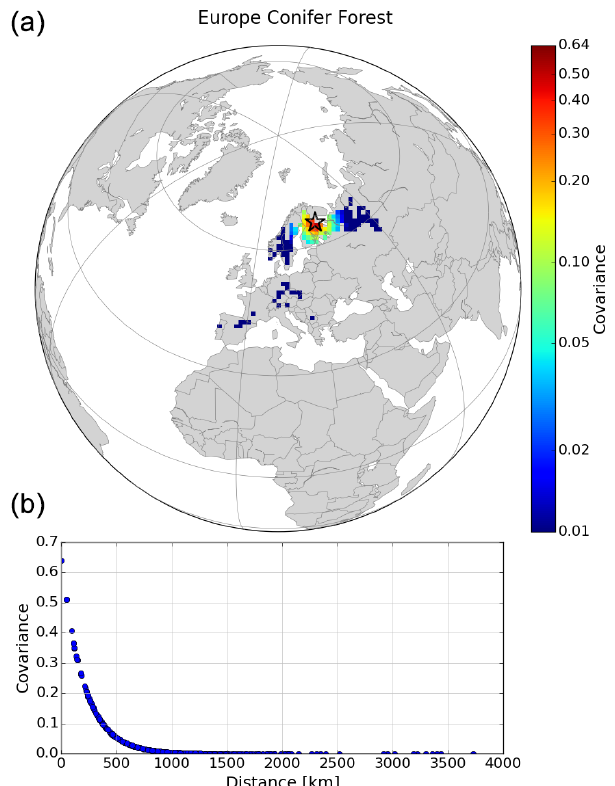
Figure 2. Error correlation in the gridded state vector setup for a specific grid box (indicated by the black star) in the European conifer forest region (with length scale 200km) with the other grid boxes in that region (a) and vs. distance (b)